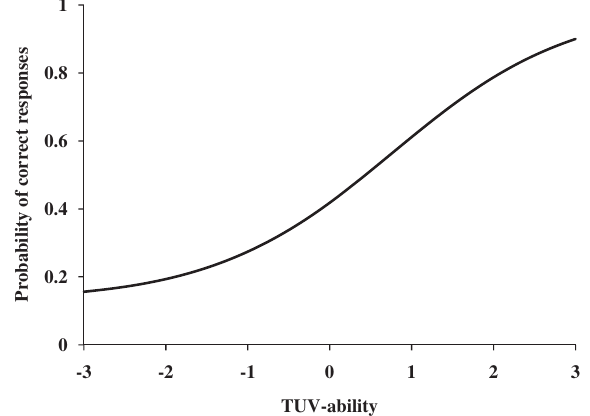
FIG. 1. Item characteristic curve (ICC) of item 1 in the TUV, modeled from data on Thai students ( N ¼ 2392